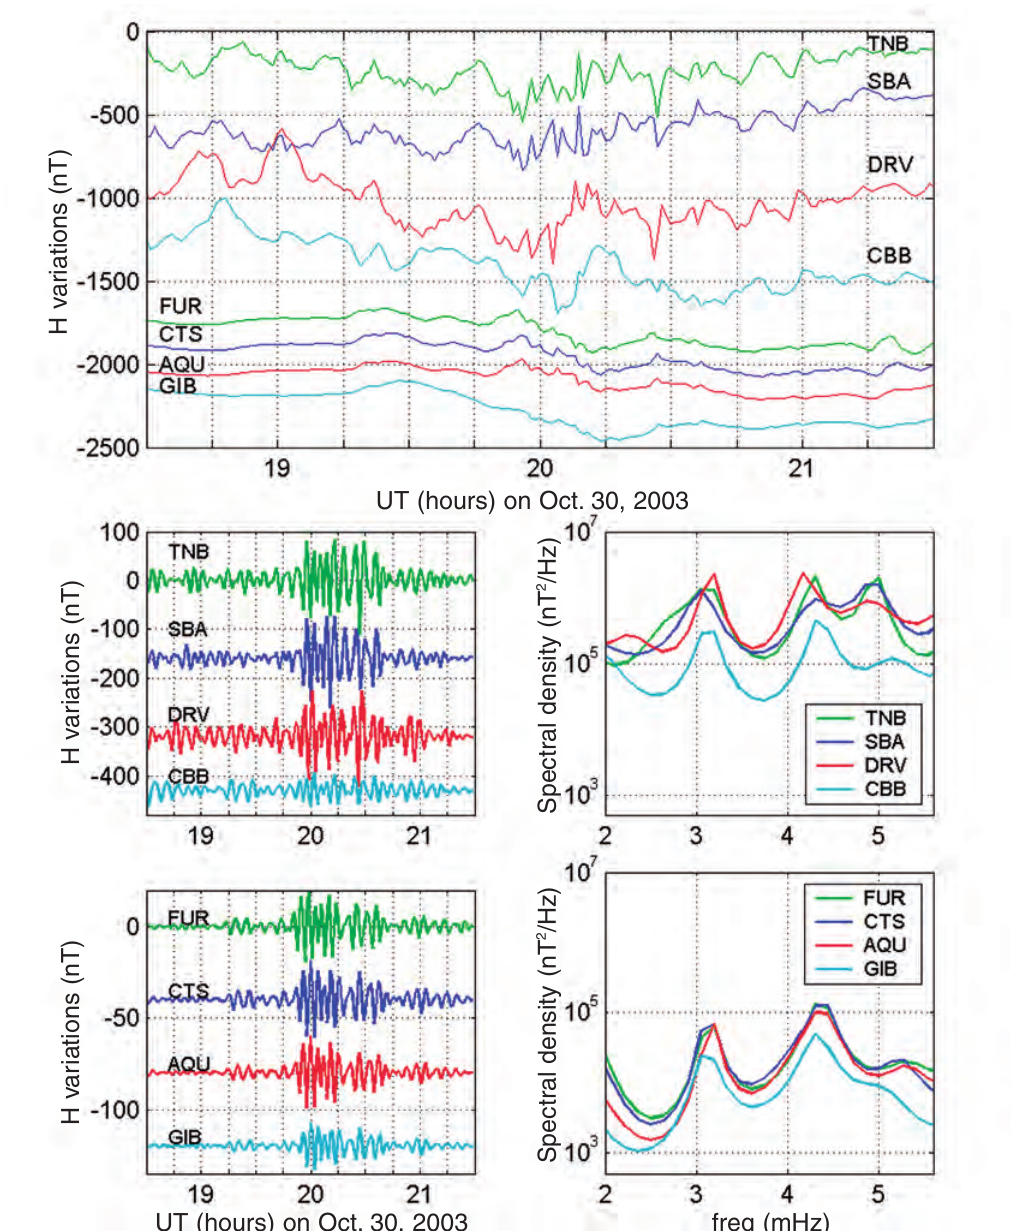
Fig. 8. Variations of the H component (unfiltered data, upper plot; 2-5 mHz filtered data, lower left plots) at four high latitude and four low latitude stations (table I) and corresponding power spectra from differenced da- ta (plots on the